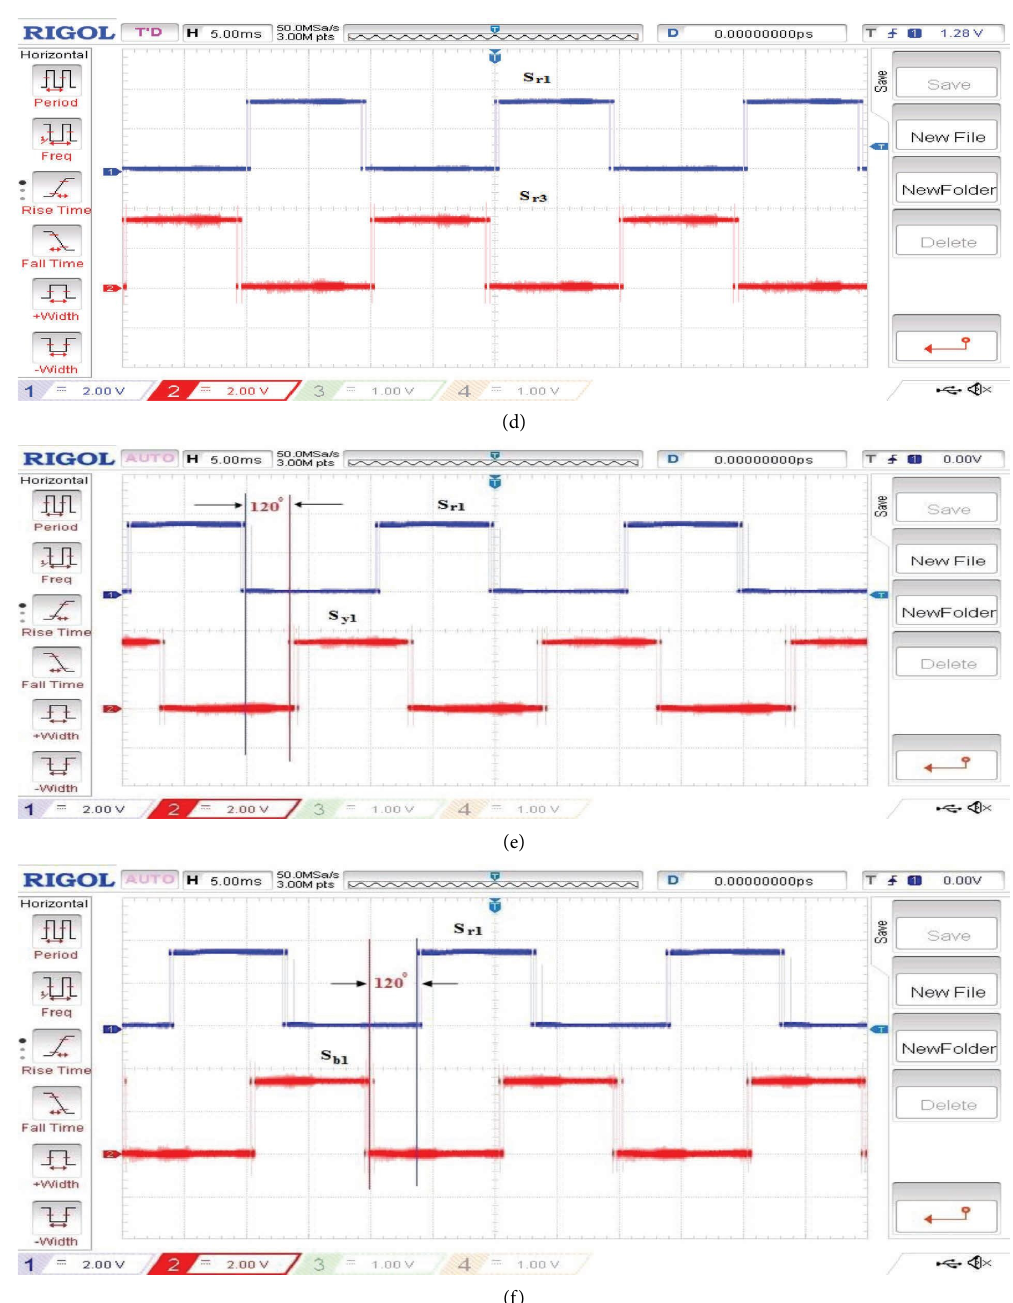
Figure 22: Experimental gating pulses for proposed three-phase topology. (a)–(d) Pulses for phase-R; (e) H-bridge pulses for phase-Y; (f) H-bridge pulses for